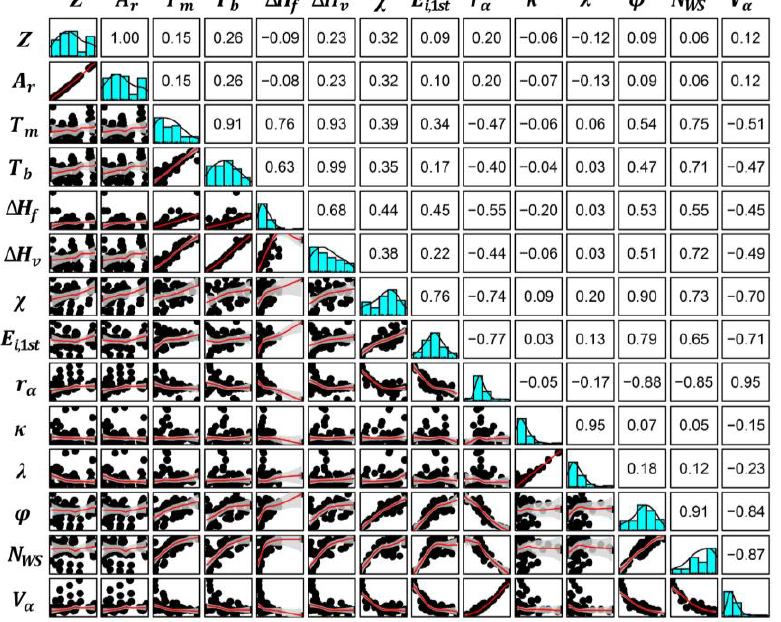
Figure 2. Correlation analysis for different intrinsic properties of elements. The diagonal squares in the matrix represent the distribution histogram of each feature. The bottom left shows the linear relationship between the two features, and the upper right numbers represent the Pearson correlation coefficients.